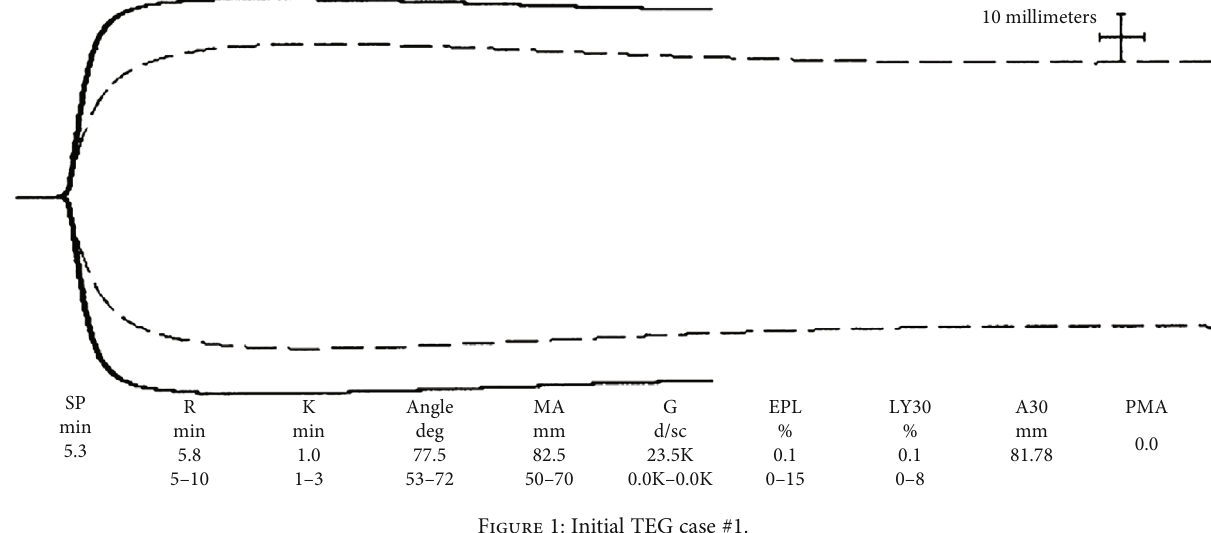
Figure 1: Initial TEG case #1.